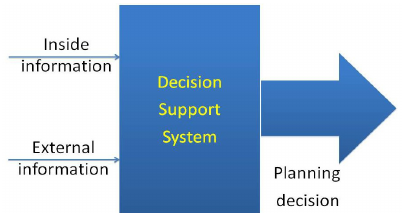
Figure 5. Decision support system internal structure